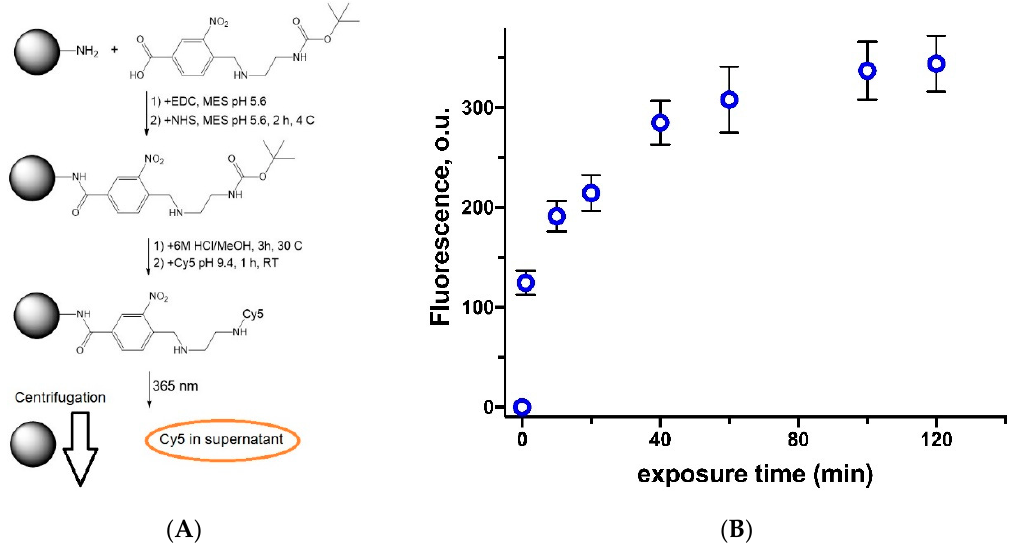
Figure 7. Study of linker decomposition after exposure to 5W LED UV lamp 365 nm: ( A ) the scheme of experiment: linker immobilization on the surface of polystyrene microparticles, Cy5 fluorescent probe attachment, exposure to the lamp and separation of microparticles by centrifugation; ( B ) the effect of polystyrene microparticles with immobilized linker exposure time on the fluorescence of released Cy5 probe in the supernatant. Conditions: 0.1 M PBS, pH 7.4; microparticles suspension concentration—5